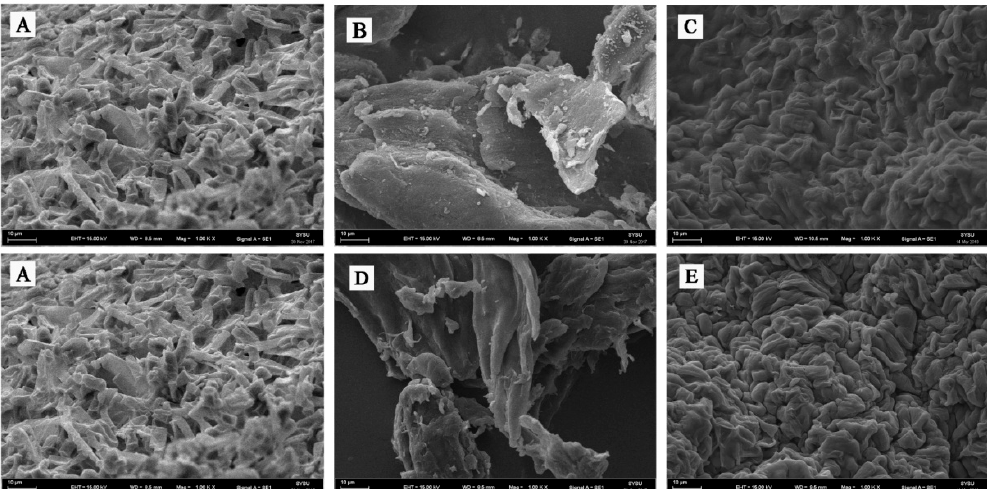
Figure 2. Scanning electron micrographs of agar and calcium alginate beads containing G. candidum AS 2.361 cells. ( A ) free cells of G. candidum AS 2.361; ( B ) agar; ( C ) G. candidum AS 2.361 cells immobilized on agar; ( D ) calcium alginate; ( E ) G. candidum AS 2.361 cells immobilized on calcium alginate.